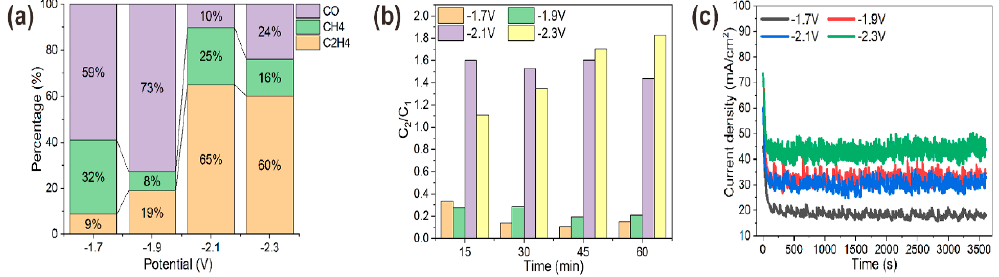
Figure 6. Selectivity characterization of operando synthesized coppers. ( a ) Three main gas products (CO, CH 4 , C 2 H 4 ) distribution under different synthesized potential. ( b ) C 2 /C 1 products ratio of copper synthesized under different potentials for electroreduction of CO 2 , monitored every 15 minutes for 1 h by gas chromotography. ( c ) Chronoamperometric i-t curves of copper synthesized under different potentials.